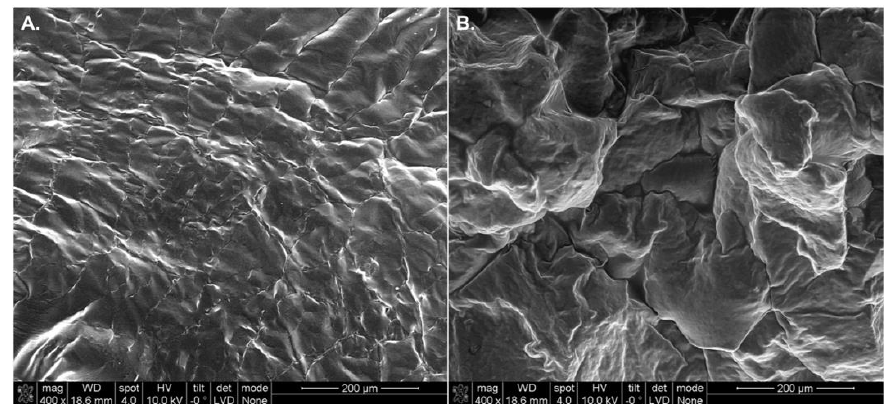
Figure 3. Cross-sectional SEM micrographs of polymerized bioinks loaded with lisinopril and spironolactone. ( A ) Lyophilized lisinopril-loaded hydrogel (40 mg/mL) with a W HANB of 3% and a r ratio of 0.6. This bioink was exposed to a T L of 2 min. ( B ) Polymerized hydrophobic ink loaded with spironolactone (20 mg/mL). This formulation contained a W PEGDA of 20% and a T L of 1 min.